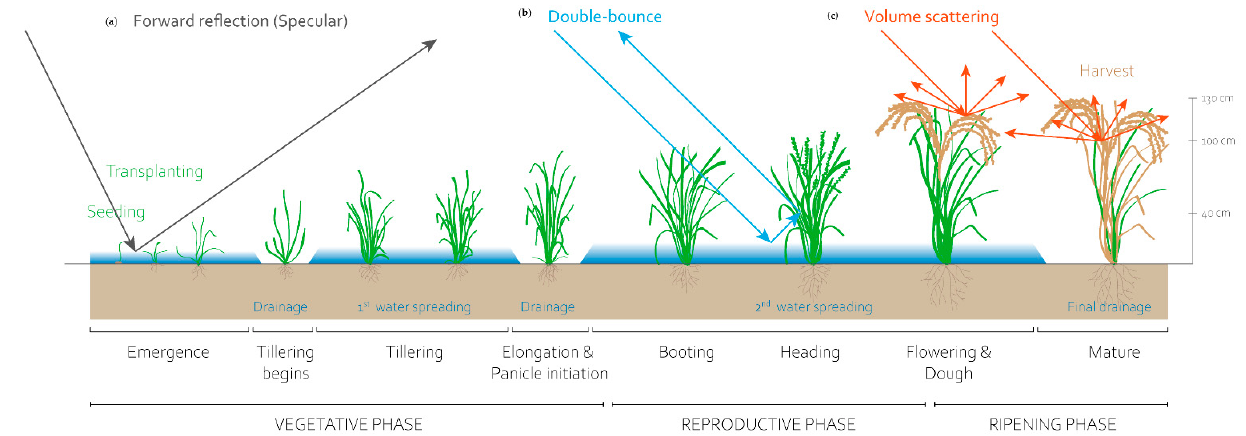
Figure 2. Schematic representation of C band backscatter mechanisms for rice (Oryza sativa) with three main phases in Mekong Delta (vegetative phase, reproductive phase and ripening phase); ( a ) forward reflection (specular); ( b ) Double-bounce; and ( c ) volume scattering.